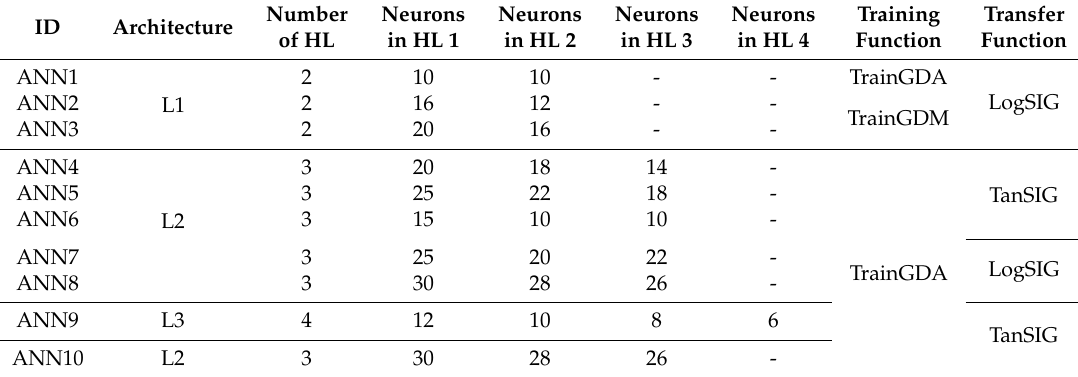
Table 1. Network configurations: architecture, number of neurons per hidden layers and